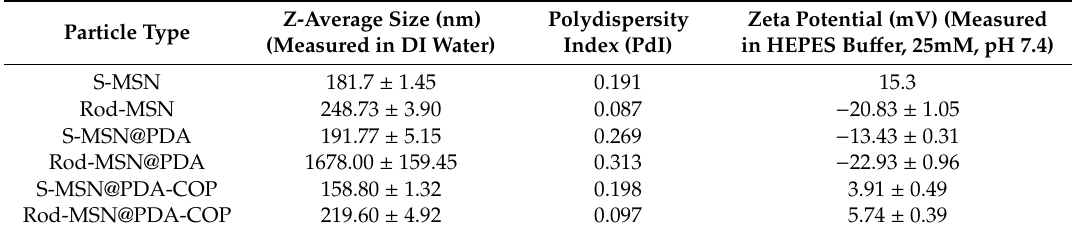
Table 1. Size and zeta potential of uncoated and polydopamine (PDA)-coated S-MSN and R-MSN with and without further PEG-PEI copolymer (COP)